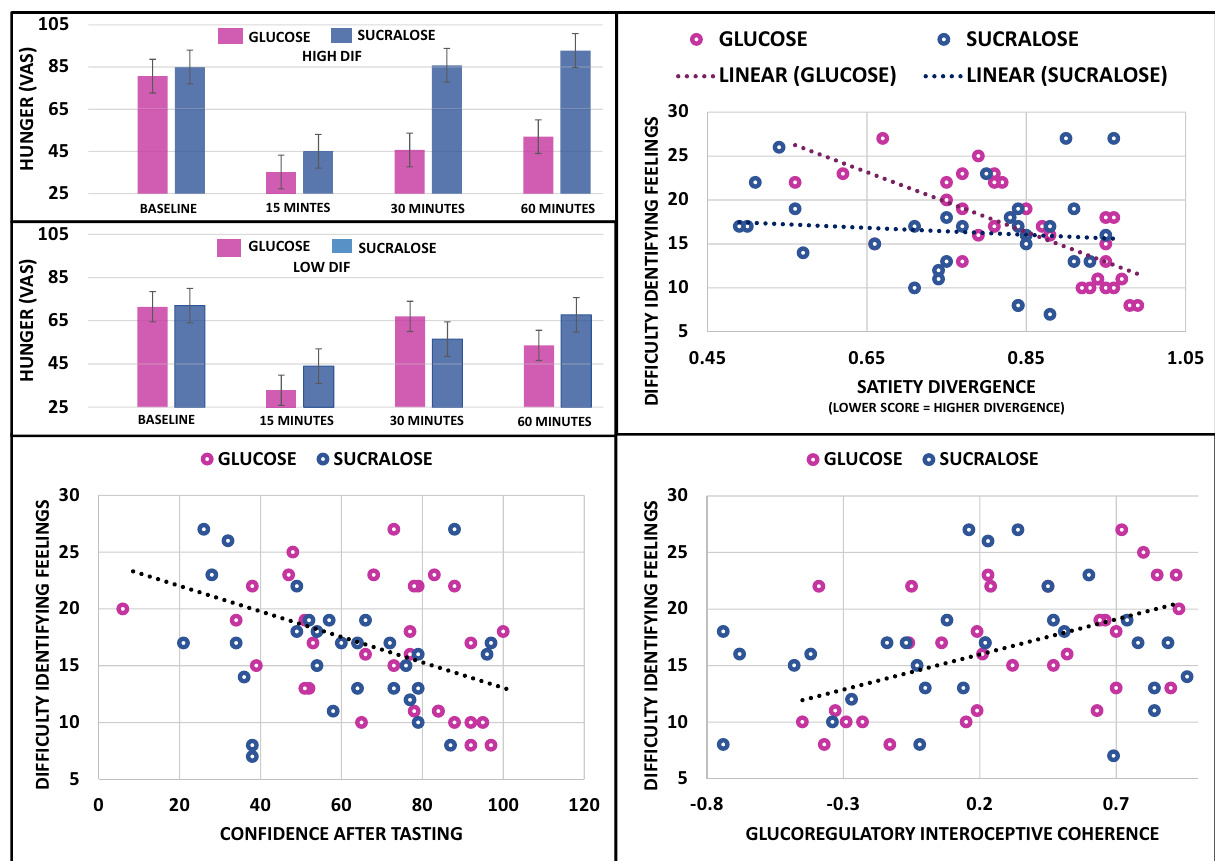
Figure 4. The effect of difficulty identifying feelings on satiety divergence, hunger, confidence and interoceptive coherence. N = 62. Top left: After 30 (p < 0.05) and 60 (p < 0.01) minutes those who consumed sucralose were hungrier but only if they were high in difficulty identifying feelings. Top right: In the glucose condition those high in difficulty identifying feelings were significantly less accurate at anticipating their satiety (greater divergence) ( r = − 0.770, p < 0.0001), however, there was no effect in the sucralose condition ( r = 0.091, p = 0.626). Bottom left: After tasting those high in difficulty identifying feelings were less confident ( r = − 0.342, p < 0.006) in their satiety expectation irrespective of whether they tasted glucose or sucralose. Bottom right: Across both conditions those high in DIF had a higher glucoregulatory interoceptive coherence ( r = 0.258, p <